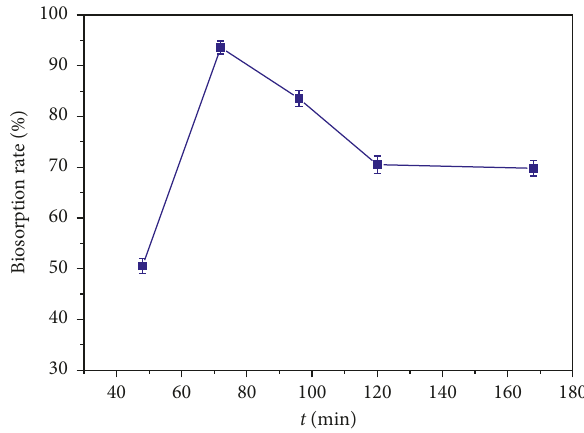
Figure 4: Effect of time on biological